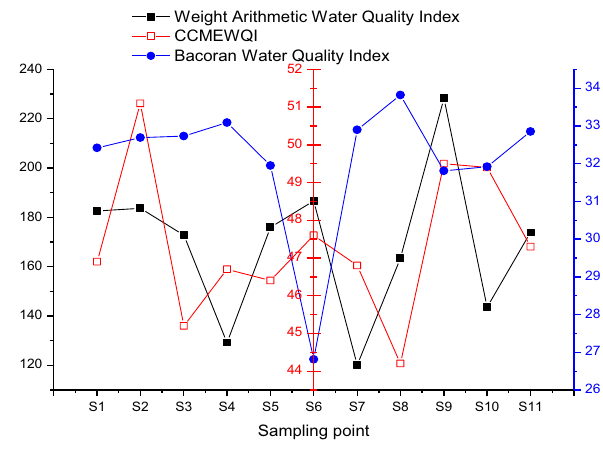
Fig. 2 Assessment of Three water quality